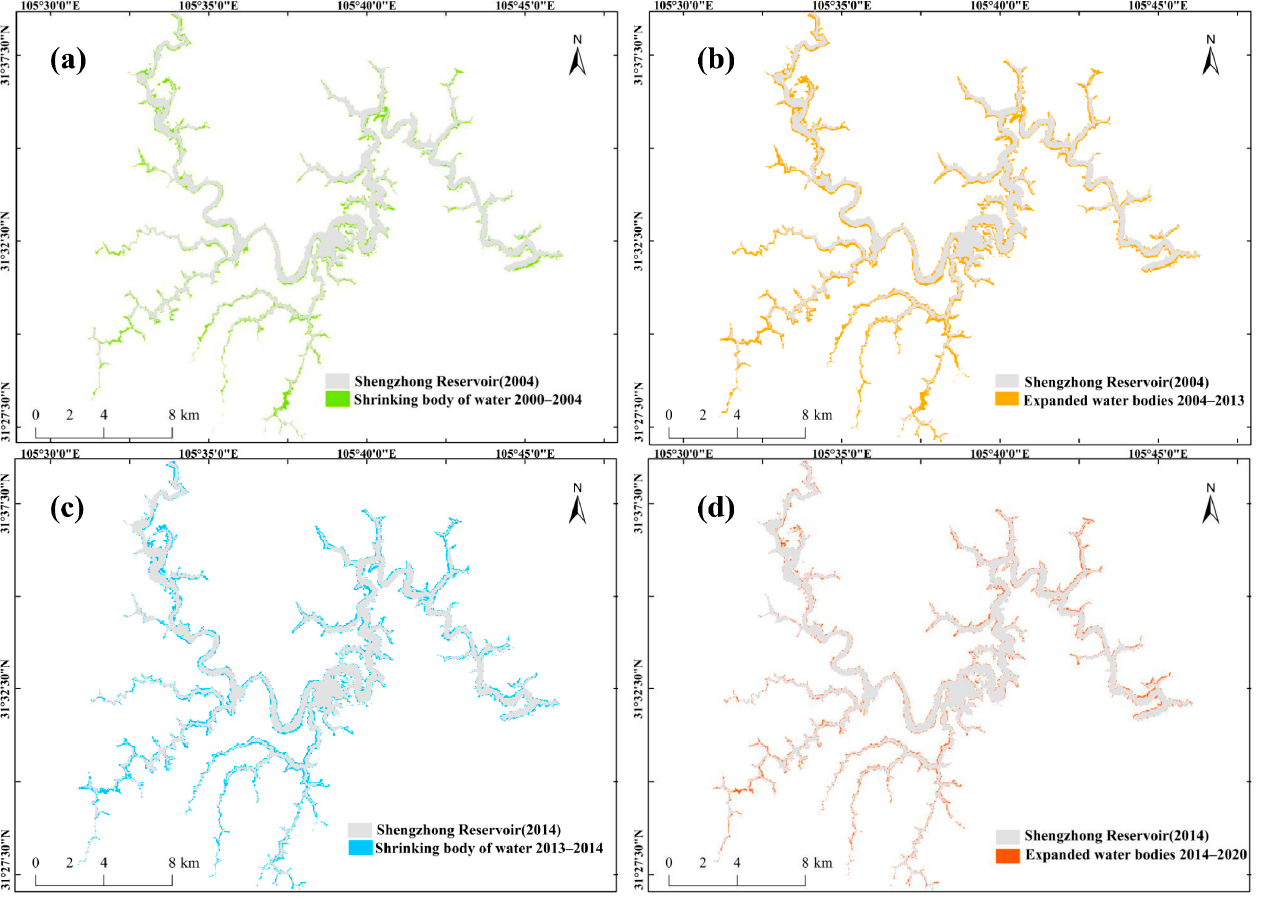
Figure 7. Spatial changes in Shengzhong Reservoir. ( a ) The shrinking water bodies of Shengzhong Reservoir during 2000 ‐ 2004; ( b ) The expansion of water bodies in Shengzhong Reservoir during the period 2004 ‐ 2013; ( c ) The shrinking water bodies of Shengzhong Reservoir during 2013–2014; ( d ) The expansion of water bodies in Shengzhong Reservoir during the period 2014–2020.